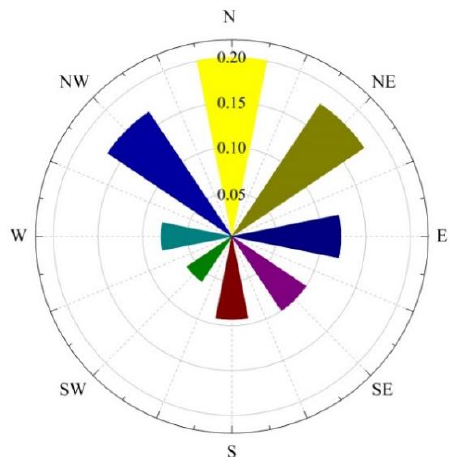
Figure 1. The proportion of fire weather data that recorded winds coming from the eight cardinal and intercardinal directions. For example, 0.20 of the fire weather wind records came from the north.